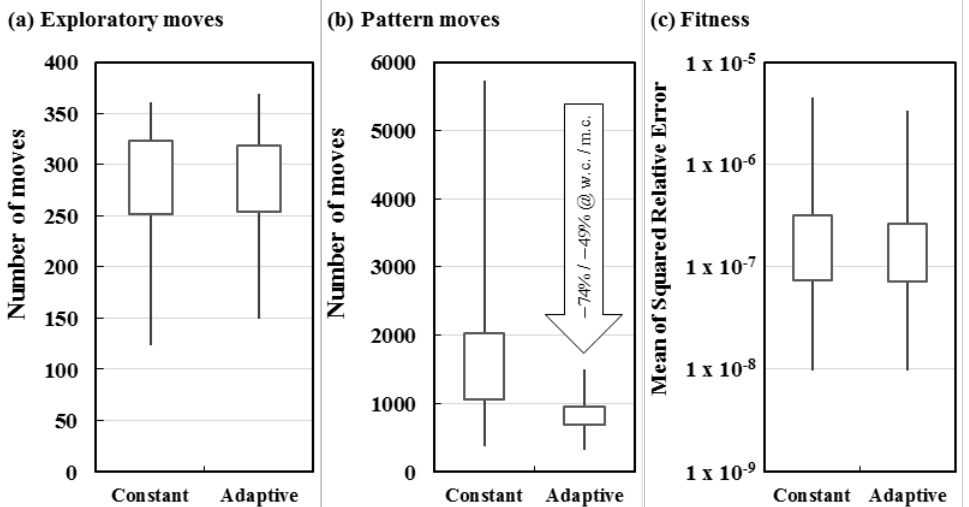
Figure 4. The benchmark results of adaptive pattern move and constant pattern move in the HJ method. To be fair in comparison, 10 samples of the target curves are randomly chosen and used on both implementations. The scale factor = 0.1 is configured in this benchmark. ( a ) The number of moves in exploratory move; ( b ) The number of moves in pattern move; ( c ) fitness distribution of the calibrated parameters; w.c. refers to worst case and m.c. refers to median case. A top/bottom edge of the whisker in the plot represents the maximum/minimum datum, respectively.